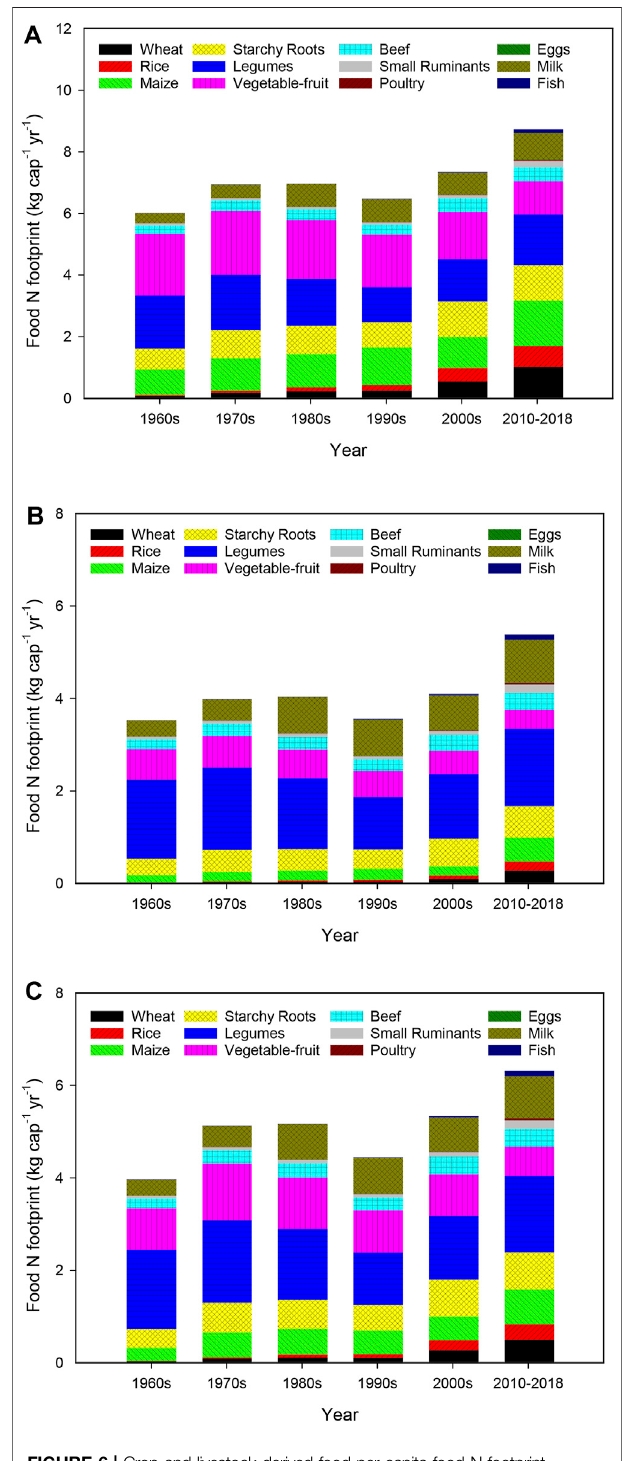
FIGURE 6 | Crop and livestock-derived food per capita food N footprint under fertilized scenario (A) , unfertilized scenario (B) , and combined scenario (C) .